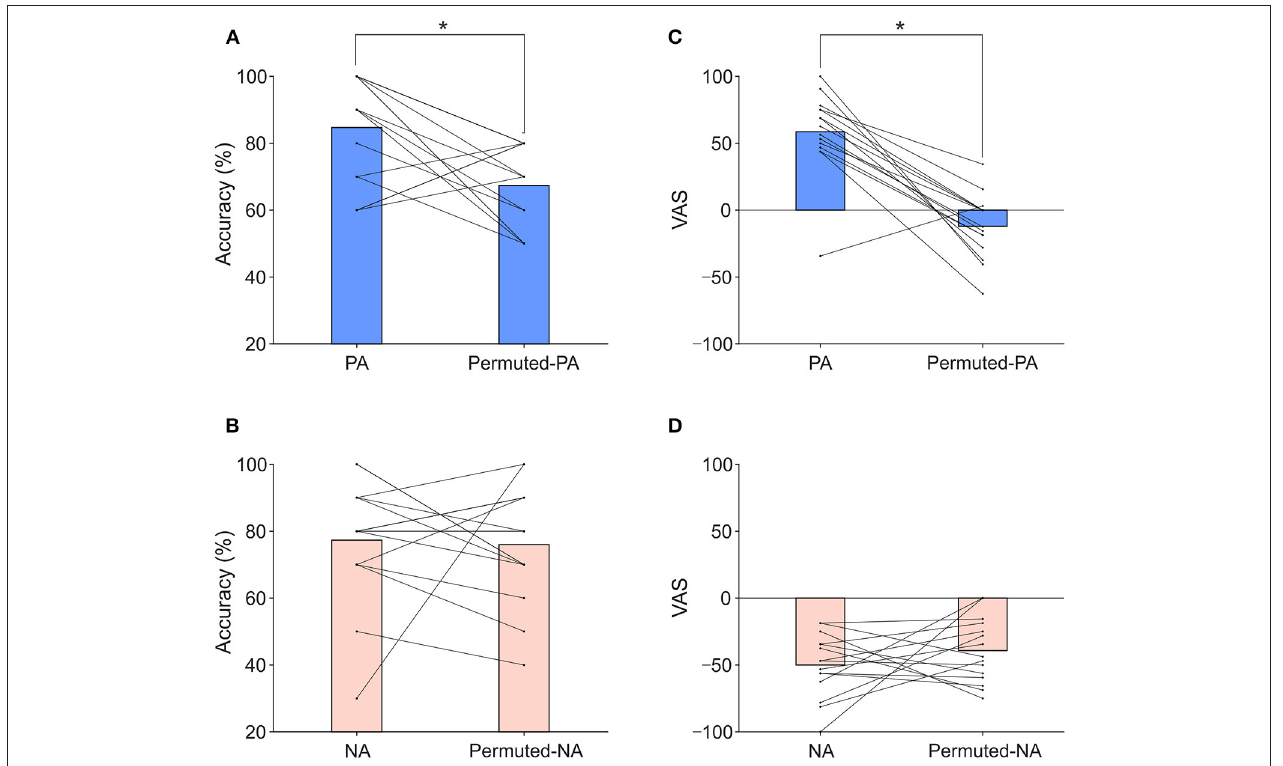
FIGURE 2 | Classification accuracies and VAS scores. (A) Classification accuracies of PA and permuted-PA. (B) VAS scores of PA and permuted-PA. (C) Classification accuracies of NA and permuted-NA. (D) VAS scores of NA and permuted-NA. The bar represents the mean classification accuracy or VAS score. The line and dot represent individual classification accuracies or VAS scores. Asterisks indicate significant differences revealed by the post-hoc test ( p <